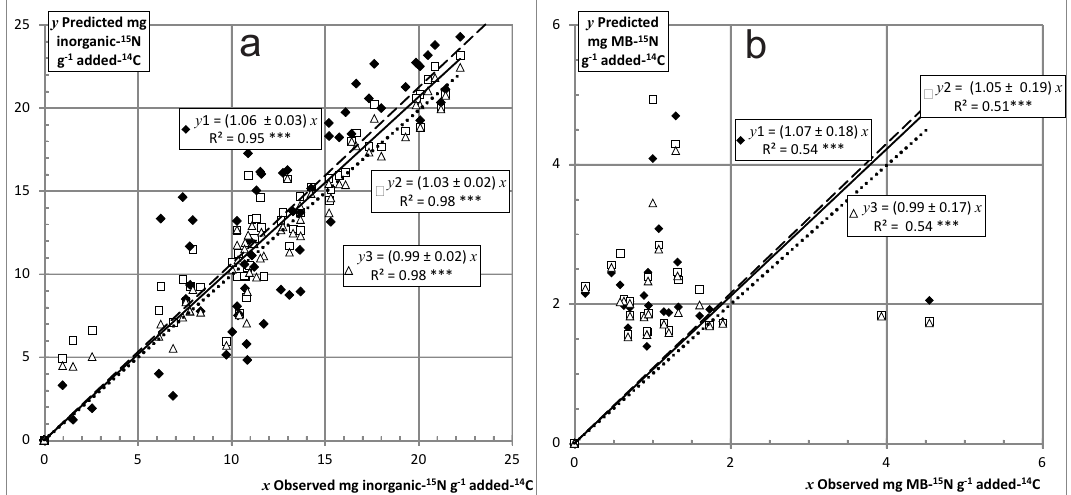
Fig. 2. Model predictions vs. observed values for the whole data set of (a) inorganic 15 N, and (b) MB- 15 N: ( y 1) assumption 1 (dashed line), ( y 2) assumption 2 and strategy (a) (solid line), or ( y 3) assumption 2 and strategy (b) (dotted